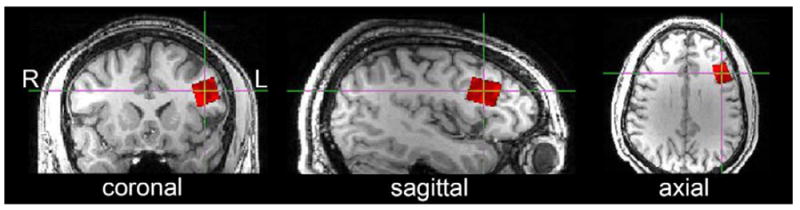
The voxel investigated in this study is depicted in orthonormal slices. The voxel
is located primarily in Brodmann Areas 45 and 46 (dlPFC; 1.5 × 2.0
× 1.5 cm).